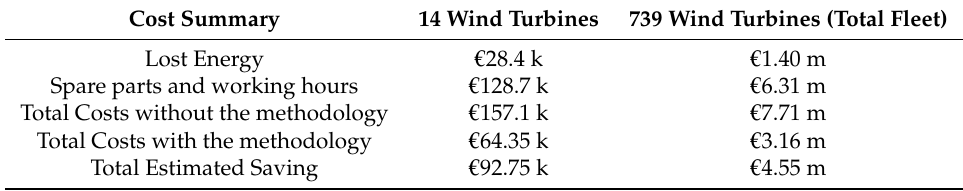
Table 4. Results of experience with the methodology and models developed for 20